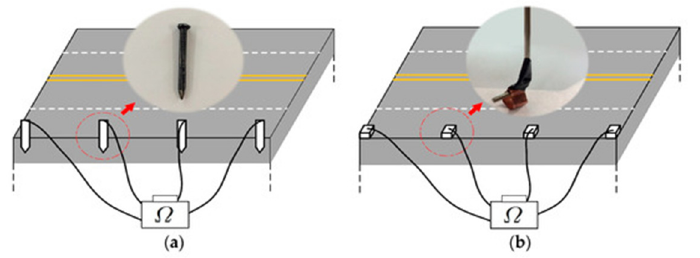
Figure 10. Two different methods exhibited in (Park et al., 2017): ( a ) the pole electrode method (PEM), and ( b ) the flat electrode method (FEM).